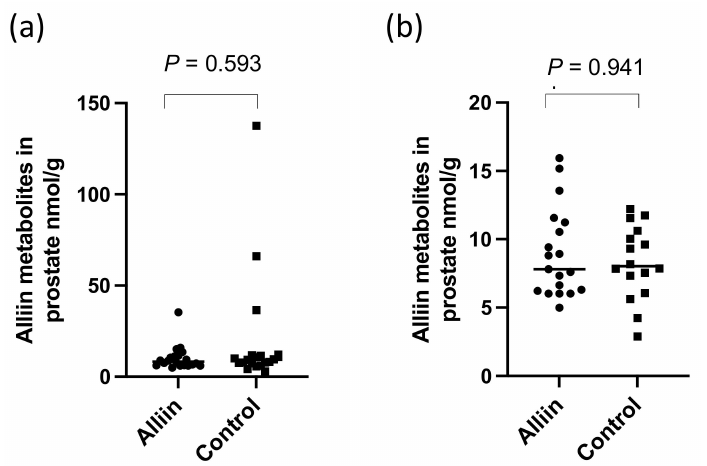
Figure 7. Alliin and associated metabolites in ( a ) prostate tissue and ( b ) with outliers removed. p -values are from Mann–Whitney tests.